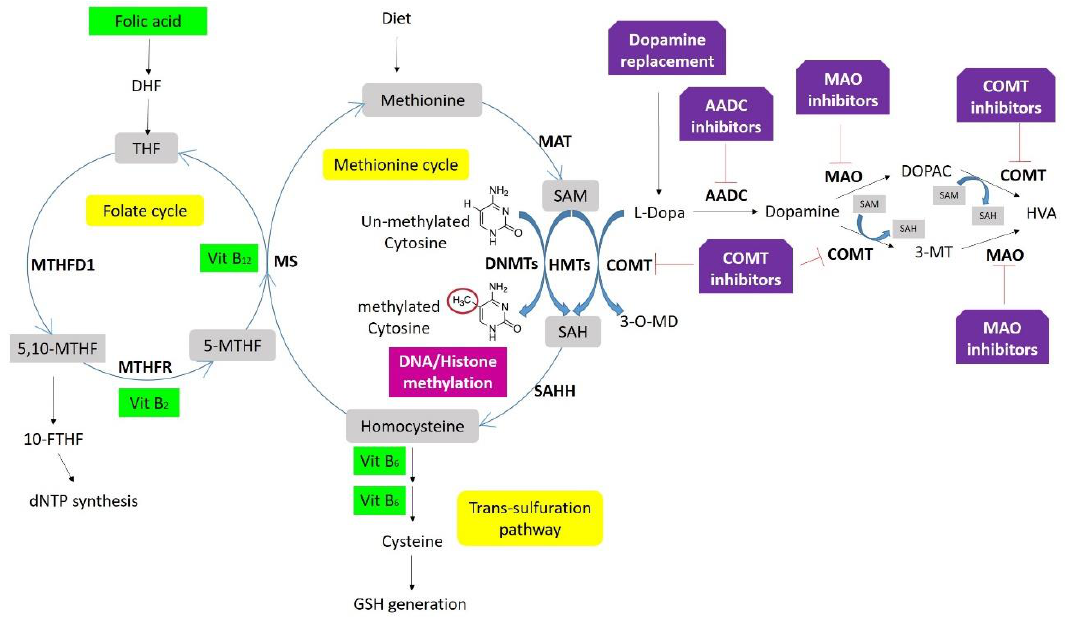
Figure 3. One-carbon metabolism, DNA/histone methylation, and drug interaction. Folate is the center of one-carbon metabolism, which involves three biochemical processes, the folate cycle, methionine cycle, and trans-sulfuration pathway. A set of enzymes (in bold) and coenzymes (in green boxes) catalyzes the different reactions. DNA methyltransferases (DNMTs) control DNA- and histone methylation through methyl groups from SAM. Deficits in folic acid and vitamins B12, B6, and B2 increase homocysteine levels inhibiting DNMTs. Dopamine replacement therapies supply L-dopamine that is converted by either catechol-O-methyltransferase (COMT) into 3-O-Methyldopa (3-OMD) by consuming methyl groups from S-adenosylmethionine (SAM), or aromatic L-amino acid decarboxylase (AADC) to generate dopamine. This dopamine can be metabolized into two substances, 3-ethoxyxtyramine (3-MT) and 3,4-Dihydroxyphenylacetic acid (DOPAC), both converted into homovanillic acid (HVA) and excreted in the urine. Both reactions are catalyzed by COMT using methyl groups from SAM, and by monoamine oxidase (MAO).